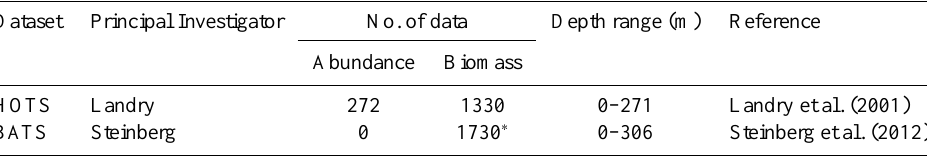
Table 1a. Summary of data points for original macrozooplankton abundance and biomass as gathered from JEGOFS long-term time-series